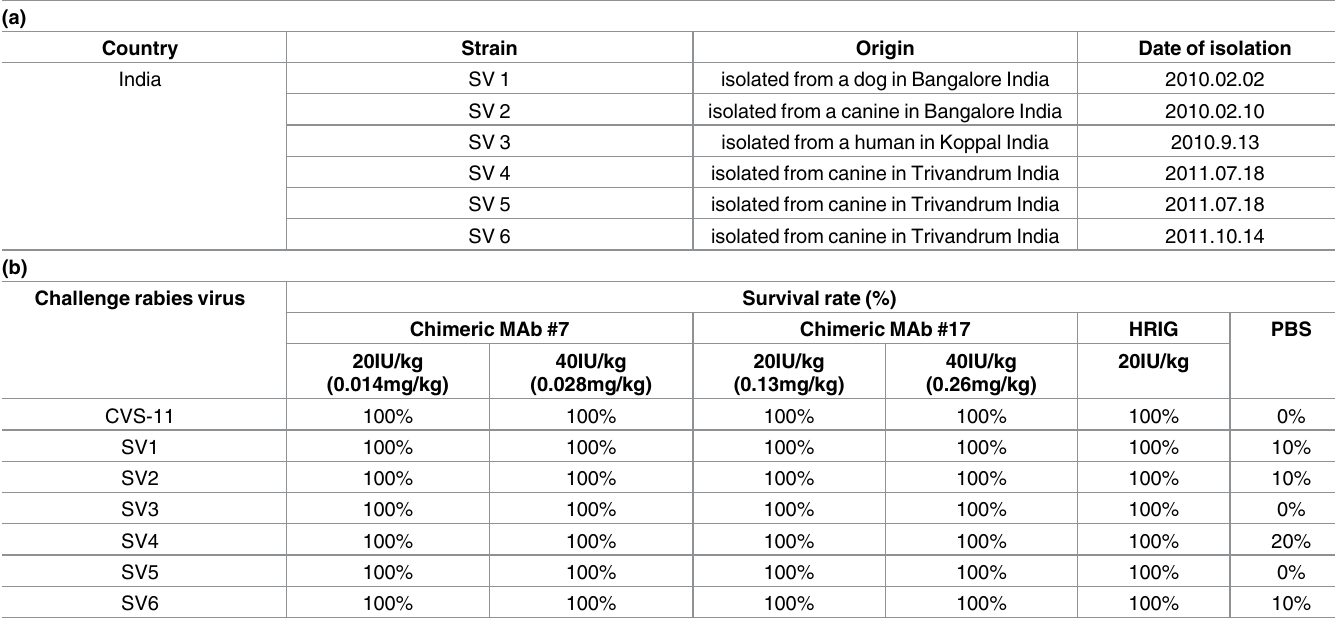
Mice were challengedwith RABV isolated in India (a) at 24 hrs before antibody treatment. Animals were injected with several concentrations of antibodies, shown in (b). Control groups received either phosphate-buffered saline or human rabies immune globulins. Animals were monitored daily for 1 month. The survival rates are shown in a table